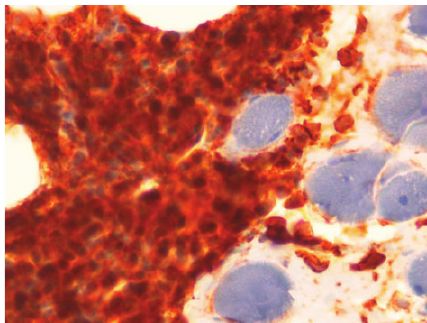
Figure 2: Histological examination of the intraoperative biopsy showing fibroadipose tissue with infiltration of immature myeloid cells (CD